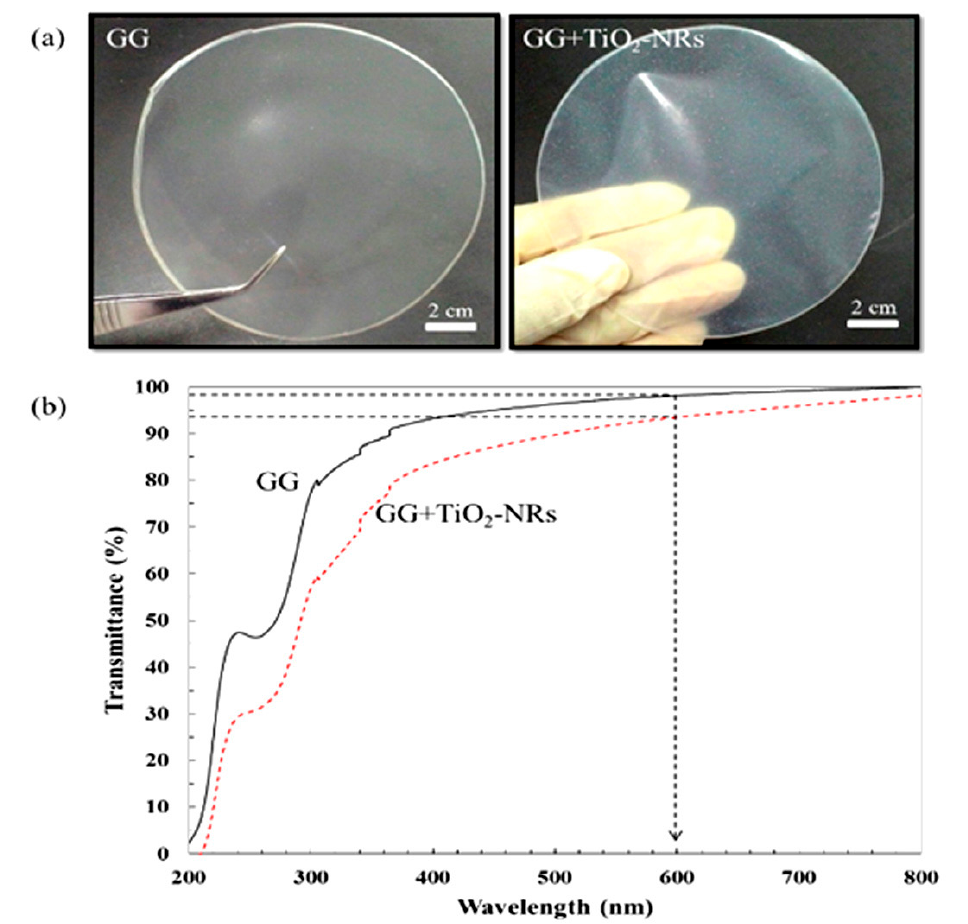
-NRs (b) UV-Vis transmittance of GG and GG+TiO 2